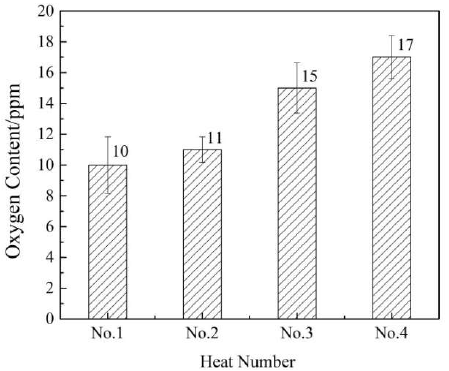
Figure 5. The oxygen content of the billets.